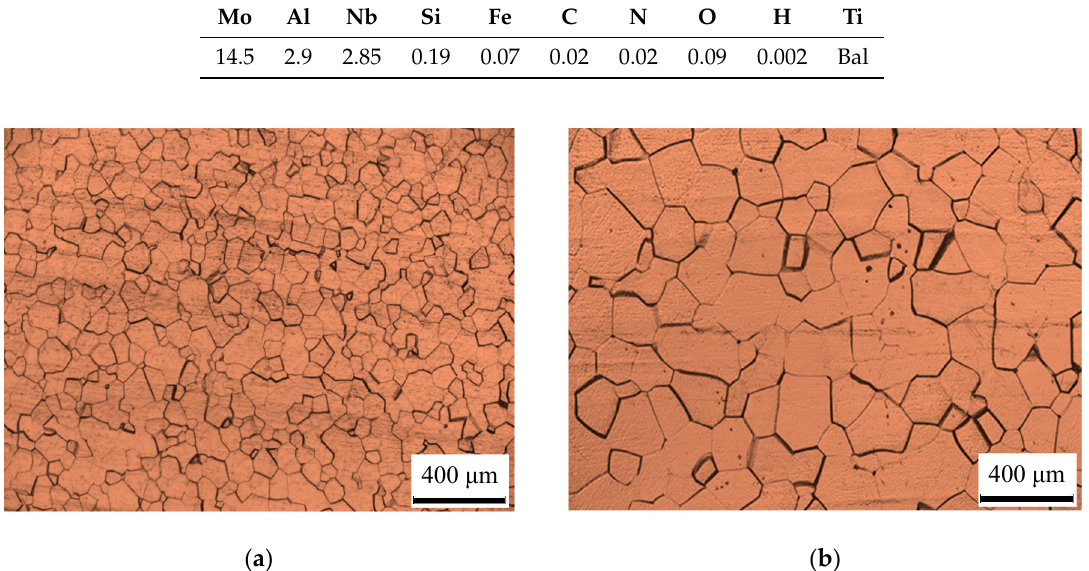
Figure 1. Microstructure of the TB8 titanium alloy after annealing at ( a ) 900 °C and ( b ) 1000 °C for 30 min.